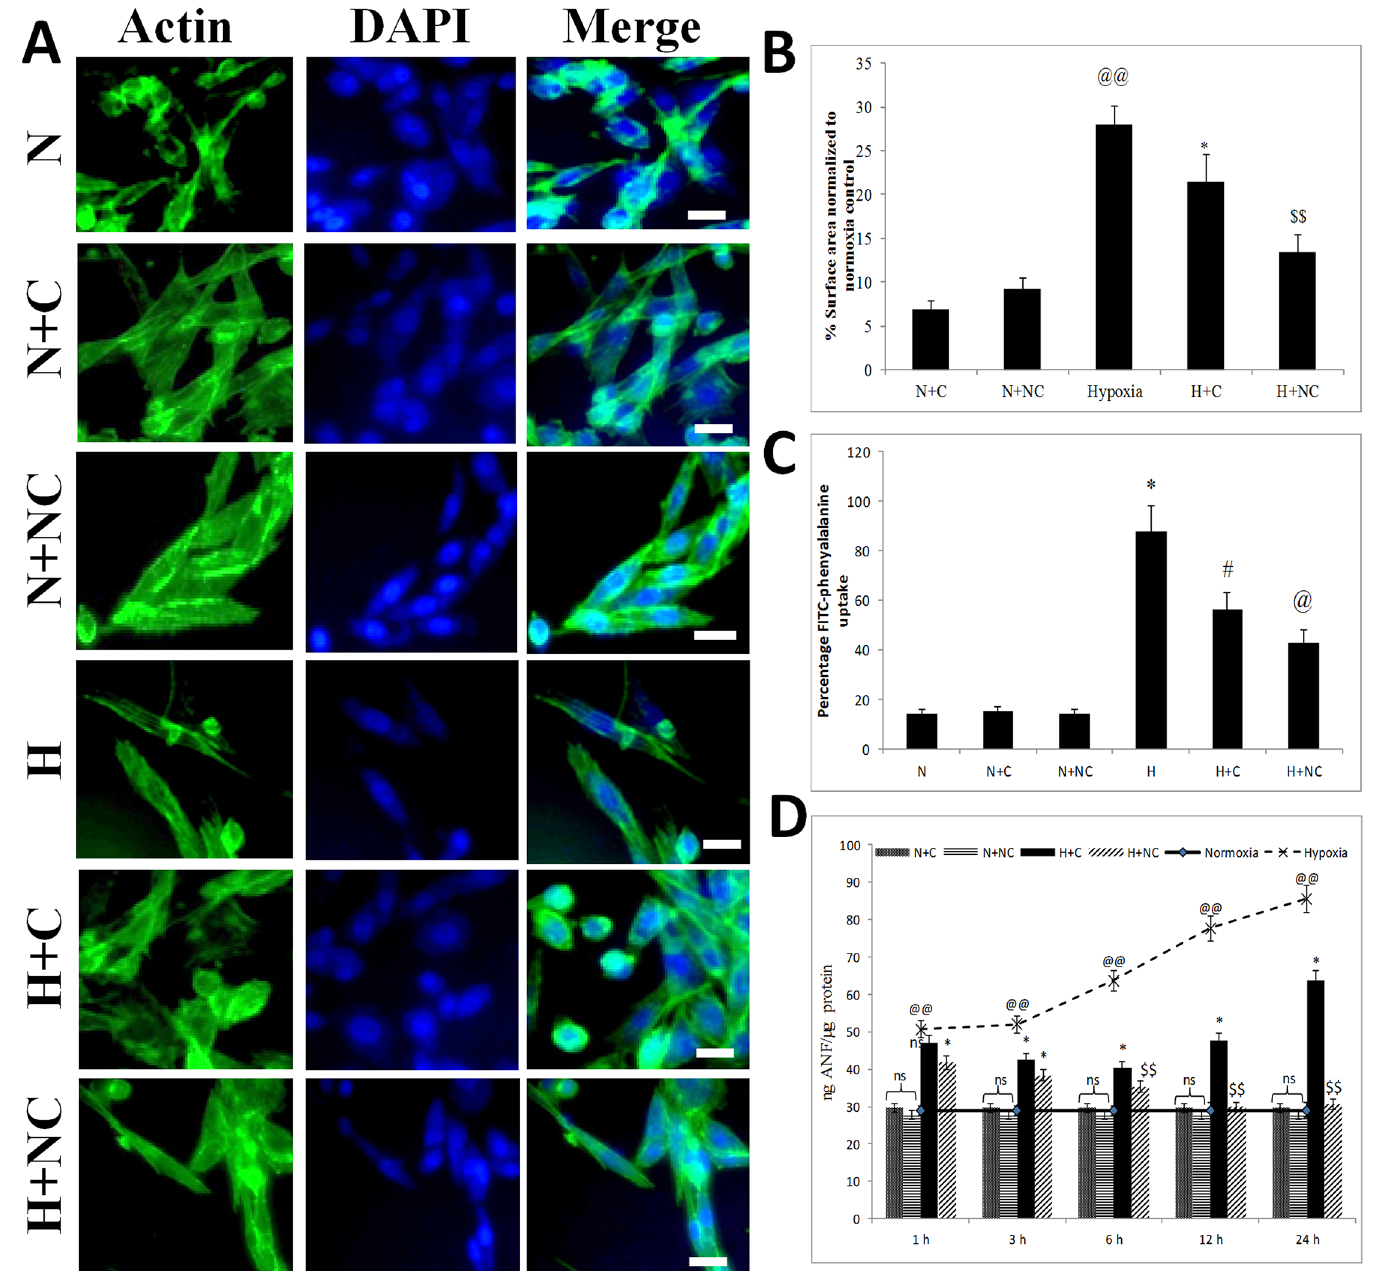
Fig 2. Nanocurcumin prevents hypoxia induced hypertrophy in HVCM cells: (A, B) Fluorescent staining of HVCM cells (60X) with actin filaments (green) and nuclei (blue) under various experimental groups showed increase in cell size in hypoxia exposed cells compared to normoxia controls. (C) Increment in FITC-phenylalanine uptake was observed in cells exposed to hypoxia compared to normoxia control. (D) Increase in ANF levels were observed within 1 h of hypoxia and reached maximum by 24 h of hypoxia. Treatment with nanocurcumin significantly restored the cell size and FITC-phenylalanine uptake under hypoxia when compared to curcumin treated cells and cells exposed to hypoxia only. Nanocurcumin treated cells showed tremendous restoration in ANF levels under hypoxia at all the time points compared to curcumin treated cells. No significant changes in ANF levels, cell size or FITC- phenylalanine uptake was observed in cells exposed to normoxia after treatment with nanocurcumin or curcumin. Values are mean ± SD, significant values represented as @@ p (cid:1) 0.01 vs normoxia, * p (cid:1) 0.05 vs hypoxia, # p (cid:1) 0.01 vs hypoxia, @ p (cid:1) 0.005 vs hypoxia and $$ p (cid:1) 0.001 vs hypoxia. Bar represents 50 μ m.